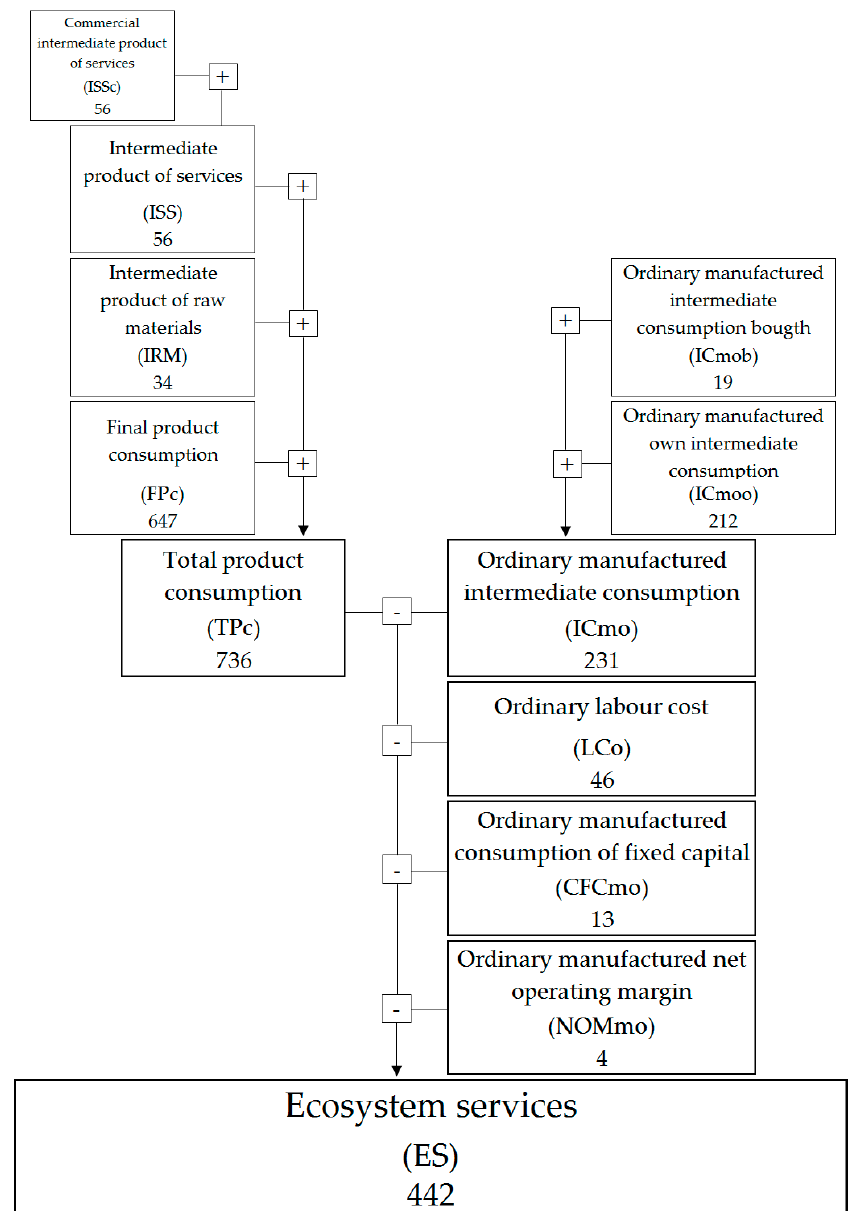
Figure 4. Agroforestry Accounting System ecosystem services at social prices for holm oak open woodlands in Andalusia (2010: €/ha).